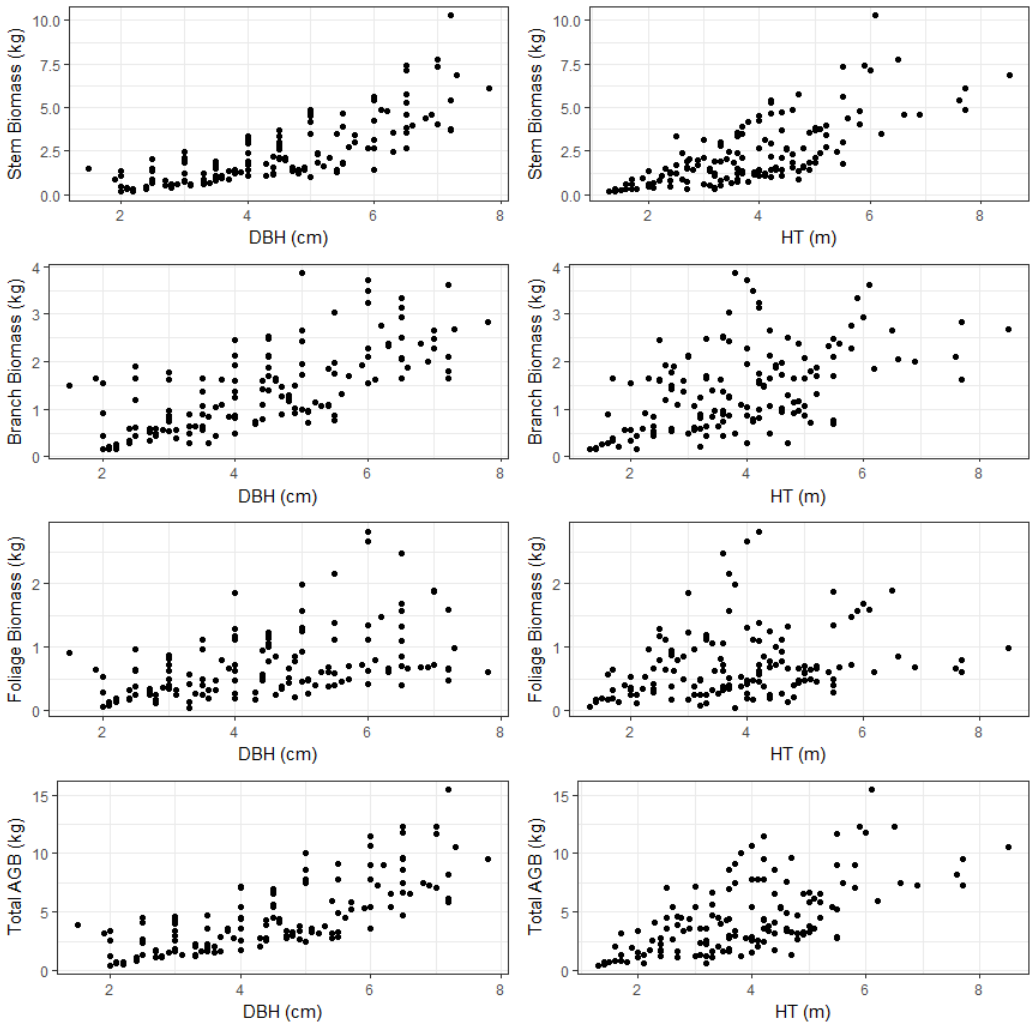
Figure 1. Sample trees of each of biomass component and total aboveground biomass (AGB) versus tree level variables for analyzed tree species. DBH and HT are diameter at breast height (cm) and total tree height (m).